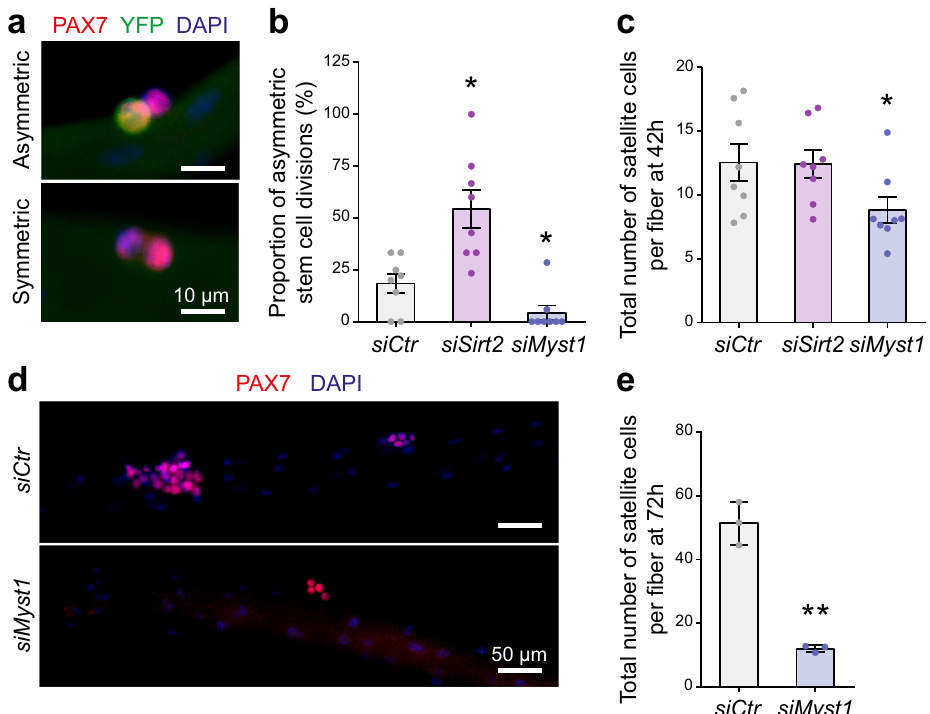
Fig. 5 MYST1 and SIRT2 control satellite stem cell self-renewal. a Representative immunostaining of an asymmetric (YFP + /YFP − ) and a symmetric (YFP − /YFP − ) satellite stem cell division on myo fi bers cultured for 42 h. Myo fi bers were immunostained with YFP (green) and PAX7 (red), and nuclei were counterstained with DAPI (blue). Scale bar represents 10 μ m. Images are representative of ≥ 90% of the divisions examined ( n = 8 mice). b Proportion of asymmetric satellite stem cell division on myo fi bers cultured for 42 h. Myo fi bers were transfected with siRNA against Sirt2 or Myst1 as indicated. Data are presented as mean values ± SEM ( n = 8 samples from independent mice) (One-way ANOVA uncorrected Fisher ’ s LSD test: * p = 0.0124 siMyst1 ; * p = 0.0193 siSirt2 ). c Number of satellite cells on myo fi bers cultured for 42 h and transfected as in ( b ). Data are presented as mean values± SEM ( n